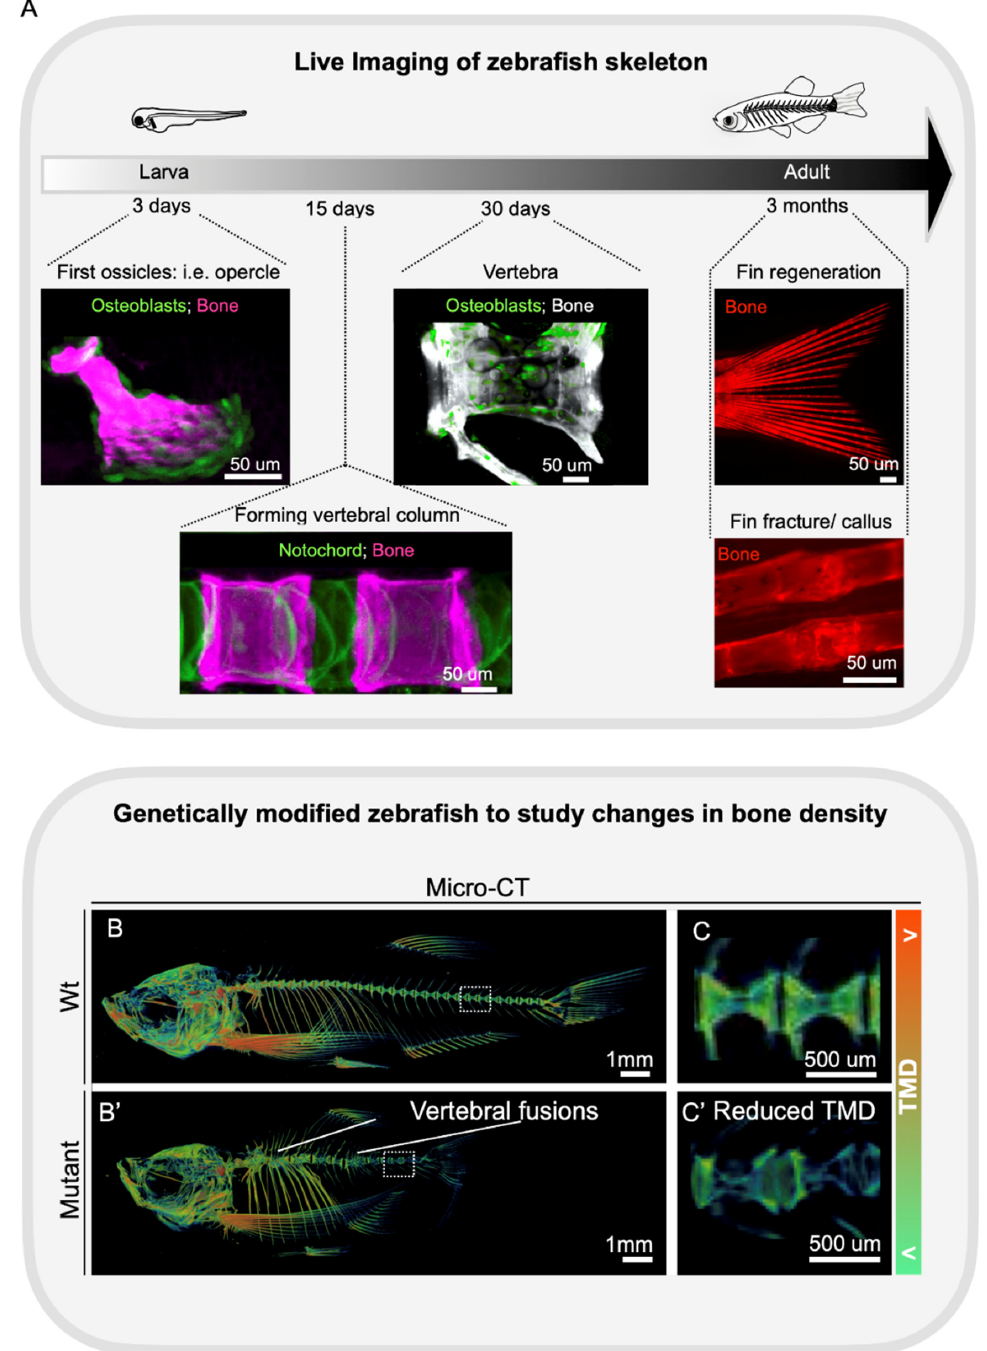
Figure 3. Phenotypic skeletal analysis in zebrafish: from in vivo cell behavior to skeletal maintenance. ( A ) The transparency of zebrafish allows us to visualize bone cells in vivo during skeletal development. Longitudinal in vivo studies frequently involve caudal fin regeneration upon amputation and fracture healing in adults. Examples include live images of reporter lines labeling osteoblasts, live staining with Alizarin Red to label the bones. ( B ) Images of volume rendering from micro-computed tomography (uCT) of adult WT and mutant (chordoma model [90]), as an example of skeletal abnormalities in mutants (vertebral fusion and lower TMD). Variations of TMD are shown color-coded. TMD scale representing <(lower TMD values) and >(higher TMD values). Higher magnification of the dashed box region in the spine is shown in ( C ). Wt ( B , C ), mutant ( B’ , C’ ). Scale bars are as